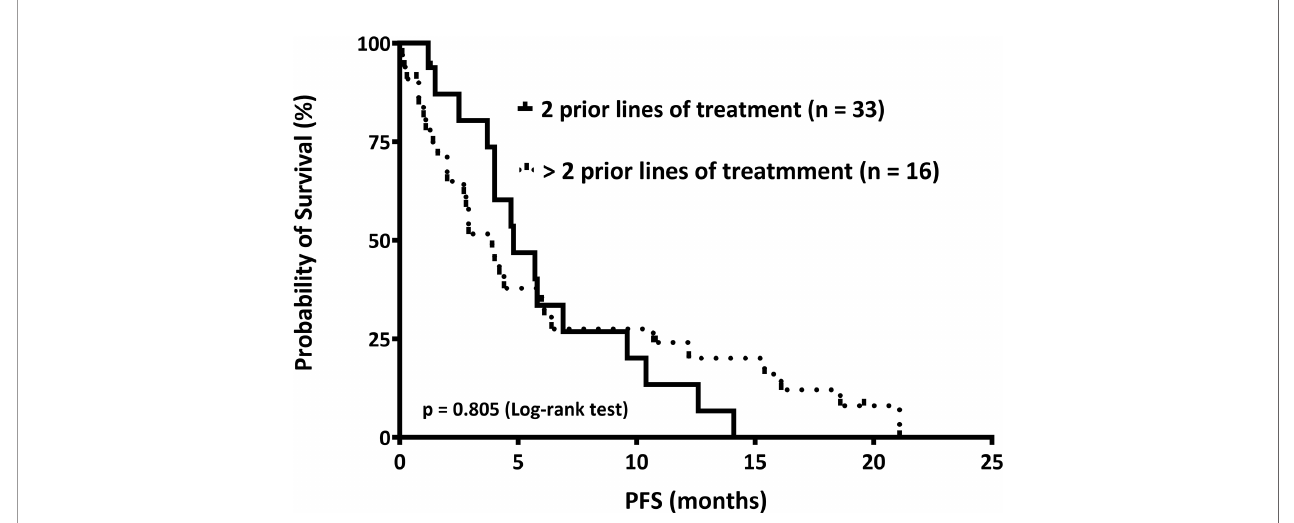
FIGURE 1 | The median progression-free survival (PFS) is shown. We strati fi ed relapsed or refractory multiple myeloma patients into two groups: those who received two (n = 33) and those who received more than two (n = 16) prior lines of treatment, according to the numbers of regimens before pomalidomide and dexamethasone therapy. The PFS of these two groups was 4.8 and 3.9 months, respectively (p = 0.805).